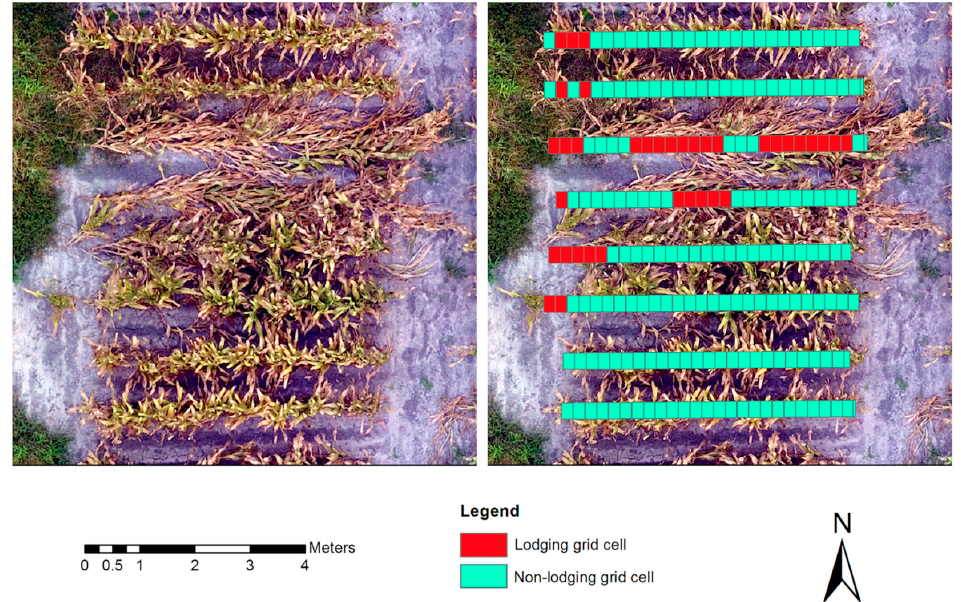
Figure 8. Demonstration of the UAS-based lodging detection over eight consecutive rows on the lower portion of the field trial. Each polygon indicates a lodging ( red ) or non-lodging grid cell ( cyan ).